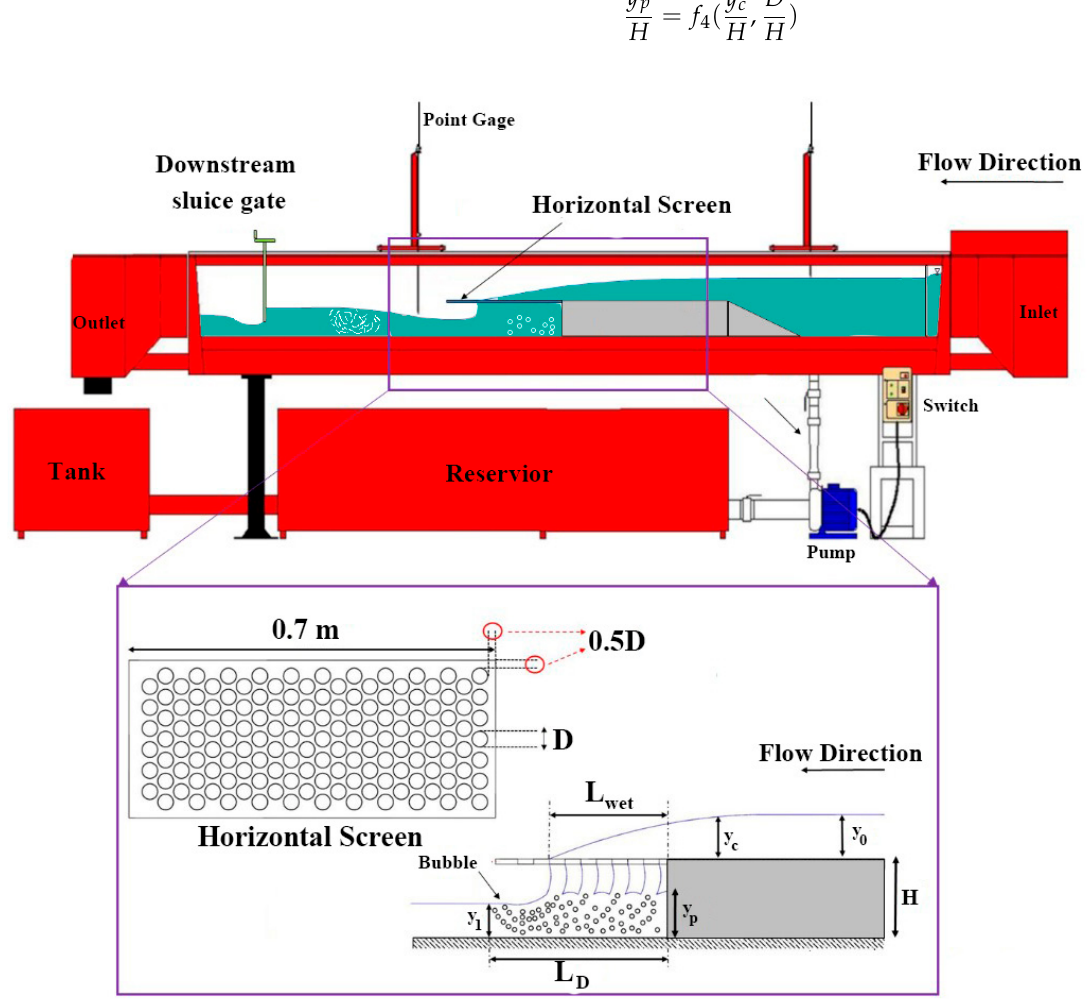
Figure 1. Schematic of laboratory flume equipped with horizontal screen.